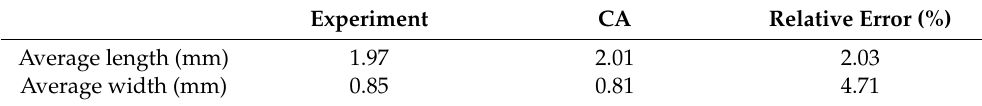
Figure 17. Schematic showing the fabricated component and samplings.